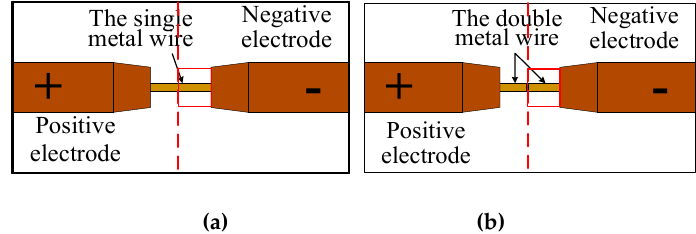
Figure 3. The simplified physical model of the resistance heating metal wire additive manufacturing. (a) A single metal wire and (b) double metal wires.